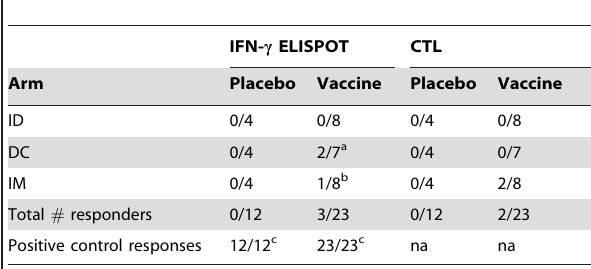
Table 2. CTL and IFN- c ELISPOT responses to any HIV